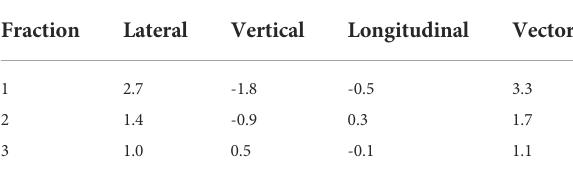
TABLE 4 Post-treatment imaging registrations with initial setup scan translational shifts. Positive shifts indicate shifts in the right, anterior and inferior direction, negative shifts indicate movement in the left posterior and superior